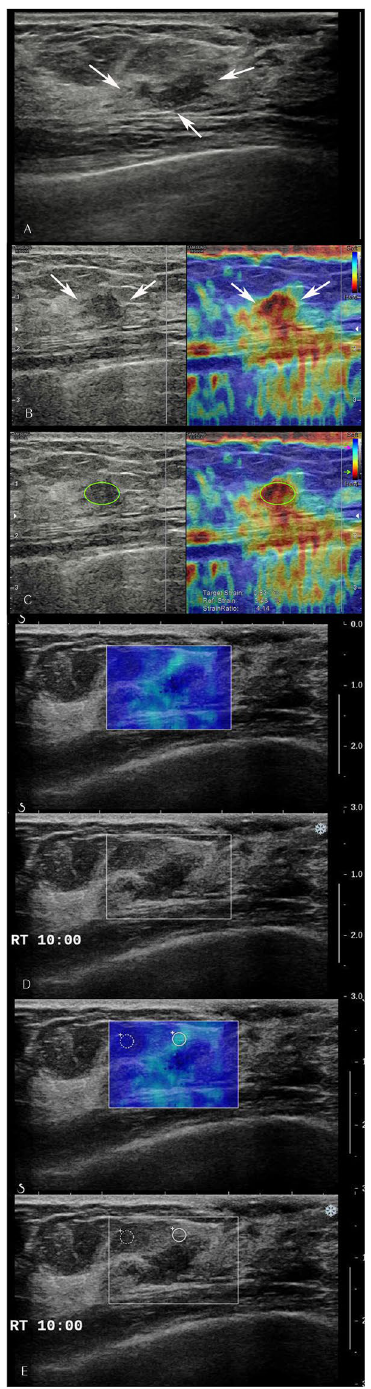
Figure 2. An abnormality detected via screening mammography in a 50-year-old woman. ( A ) Grayscale ultrasound shows an indistinct irregular isoechoic mass (arrows) in the 10 o’clock area of the right breast which was categorized as a category 4a tumour with low suspicion of malignancy. ( B ) By strain elastography, the mass was graded with a visual score of 5 according to the Tsukuba system (arrows). ( C ) Strain ratio was 4.1. ( D ) By shear wave elastography, the mass was graded with a colour score of 3. ( E ) Elasticity ratio was 5.41. Ultrasound core biopsy confirmed the tumour to be a ductal carcinoma in situ